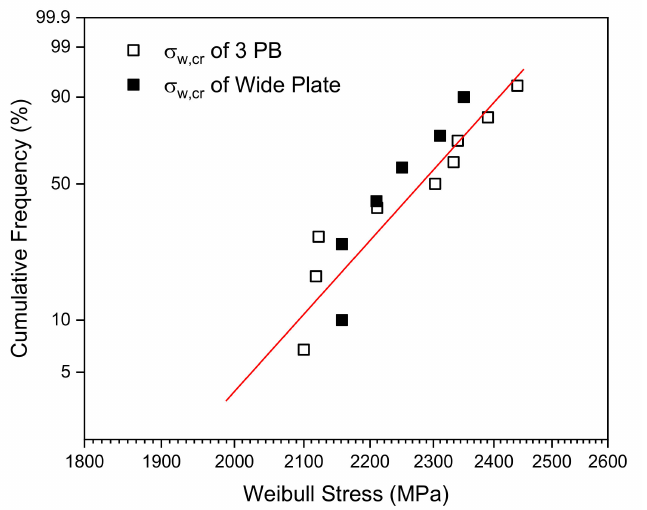
Figure 14. Critical Weibull stress distributions for 3PB and WP specimen fracture toughness test